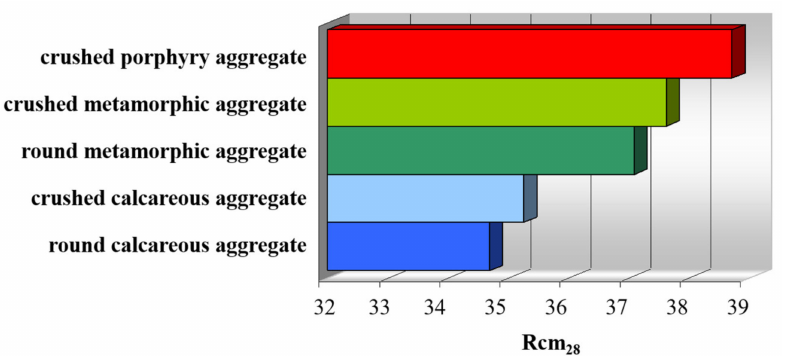
Figure 8. Comparison of the average values of compressive strengths (Rcm 28 ) on the five different mixtures obtained: red corresponds to crushed porphyry aggregate; light green to crushed metamor- phic aggregate; green to round metamorphic aggregate; light blue to crushed calcareous aggregate; blue to round calcareous